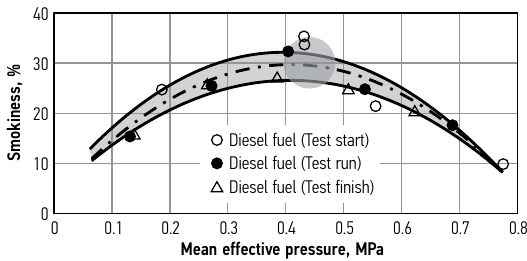
Fig. 3. The dependence of the smokiness SM of 1Z diesel engine on mean effective pressure P me when the engine runs on diesel fuel